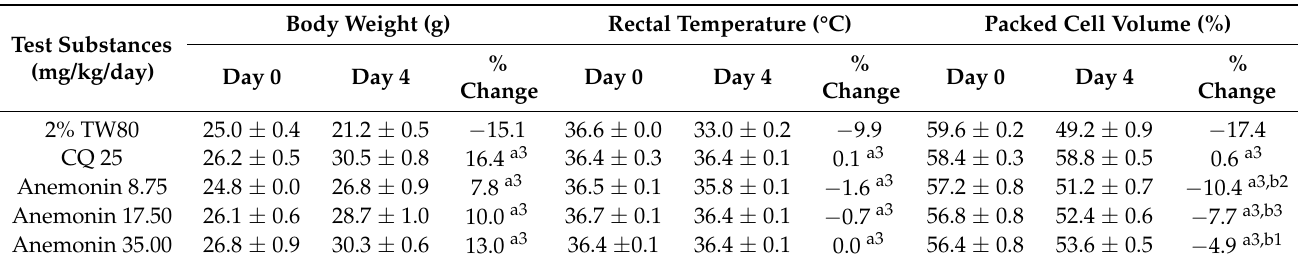
Table 5. Effect of anemonin on body weight, rectal temperature, and packed cell volume of mice infected with Plasmodium berghei in four-day suppressive antimalarial